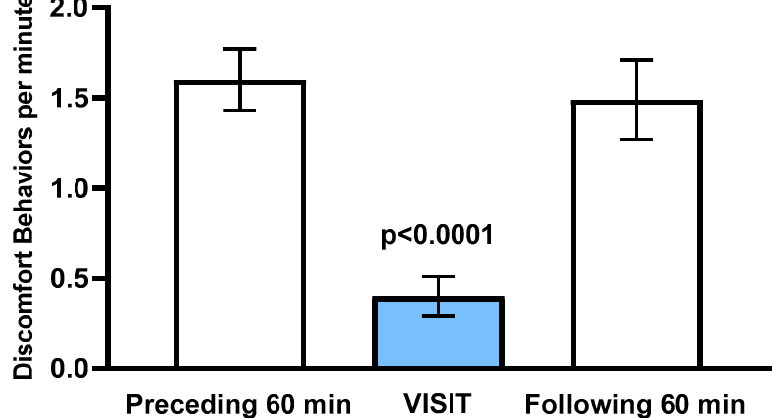
Figure 2. Mean ± S.E. discomfort behaviors per minute during the 60 min preceding a caretaker visit, during a caretaker visit (blue), and 60 min following a caretaker visit, n = 20 patients.